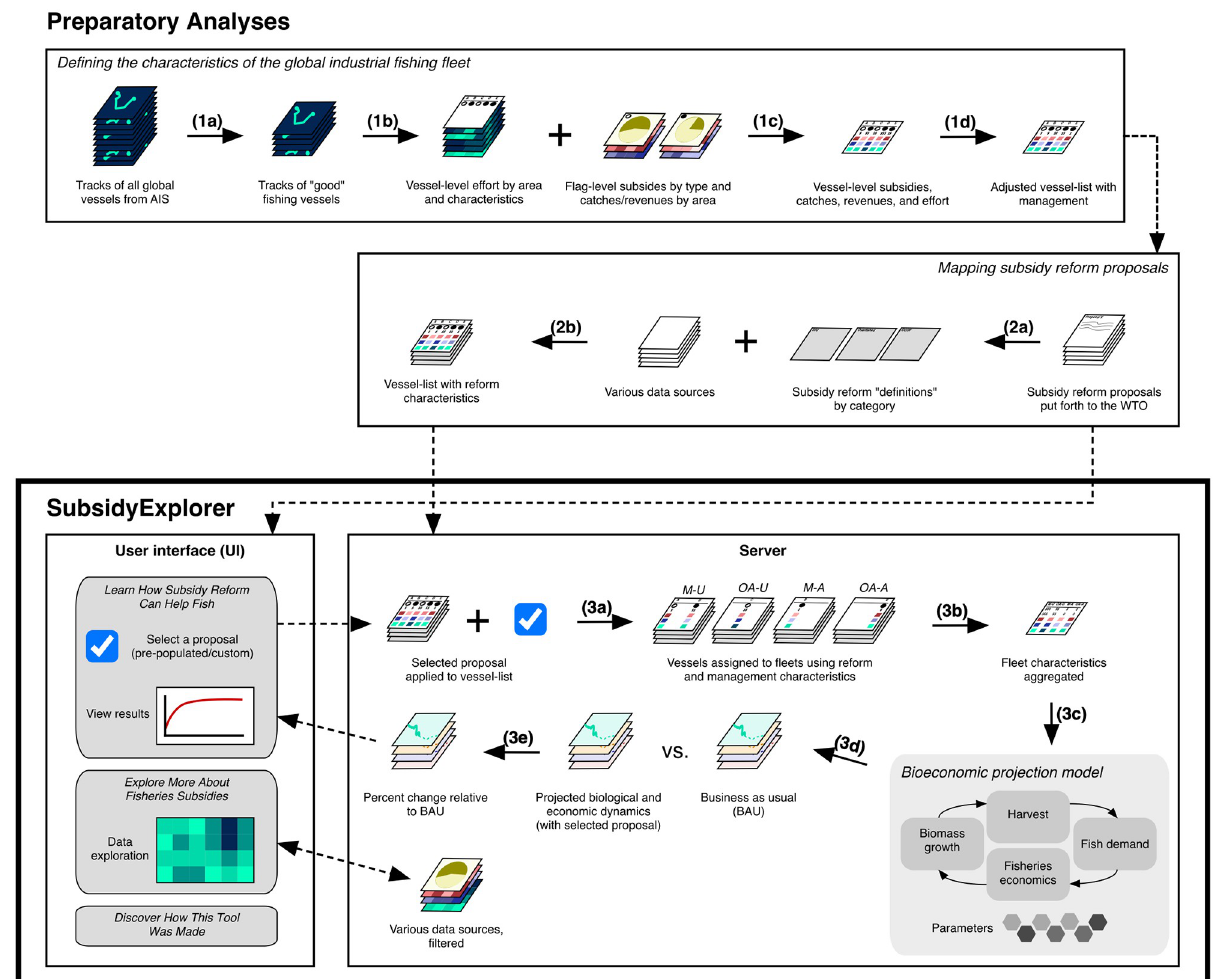
Fig 1. Conceptual schematic of the data, analyses, and processes underlying the SubsidyExplorer toolkit. The first box (steps 1a—1d) illustrates the process of combining data sources to create a dataset that defines the activities of the global industrial fishing fleet—described in the text in subsection “Defining the characteristics of the global industrial fishing fleet”. The second box (steps 2a—2c) represents the process of mapping subsidy reform proposals submitted to the WTO on to the global vessel database—to allow for their effects to later be modeled—and is described in the text in subsection “Modeling subsidy reform proposals”. The products created in the first two series of steps feed into SubsidyExplorer, but the component analyses are not contained within the toolkit itself. The final two boxes contained within the bolded outline represent the user interface and server of the SubsidyExplorer tool, and the happenings that occur therein. Steps 3a—3d illustrate the process of running the model and generating results when a user selects a subsidy reform proposal—described in the text in subsections “Bioeconomic projection model” and “Characterization of fishing fleets and their